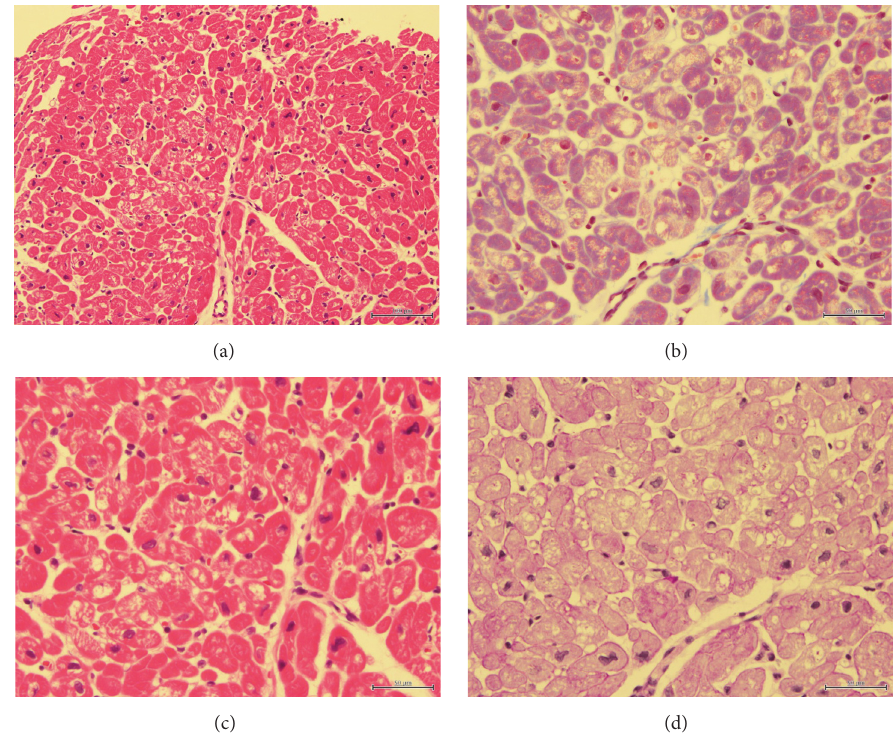
Figure 3: Photographs showing histopathological endomyocardial biopsy of the left ventricle. (a) Hematoxylin and eosin stain; scale bar = 100 𝜇 m. (b) Hematoxylin and eosin stain; scale bar = 50 𝜇 m. Vacuolar degeneration and hypertrophy of myocardium of LV; no interstitial edema; no inflammatory cell infiltrate. (c) (Masson’s trichrome stain) interstitial fibrosis of myocardium. (d) (Periodic acid-Schiff stain) no accumulation of